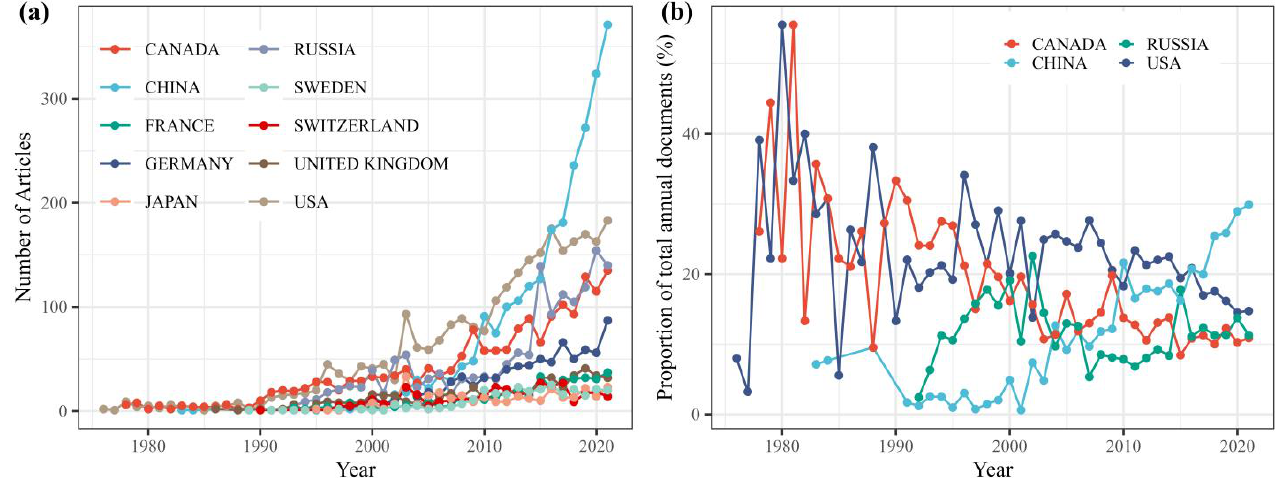
Figure 5. Statistical information about permafrost publications by country: ( a ) annual scientific production of the top ten countries and ( b ) annual proportions of the countries with a cumulative number of documents over 1000.